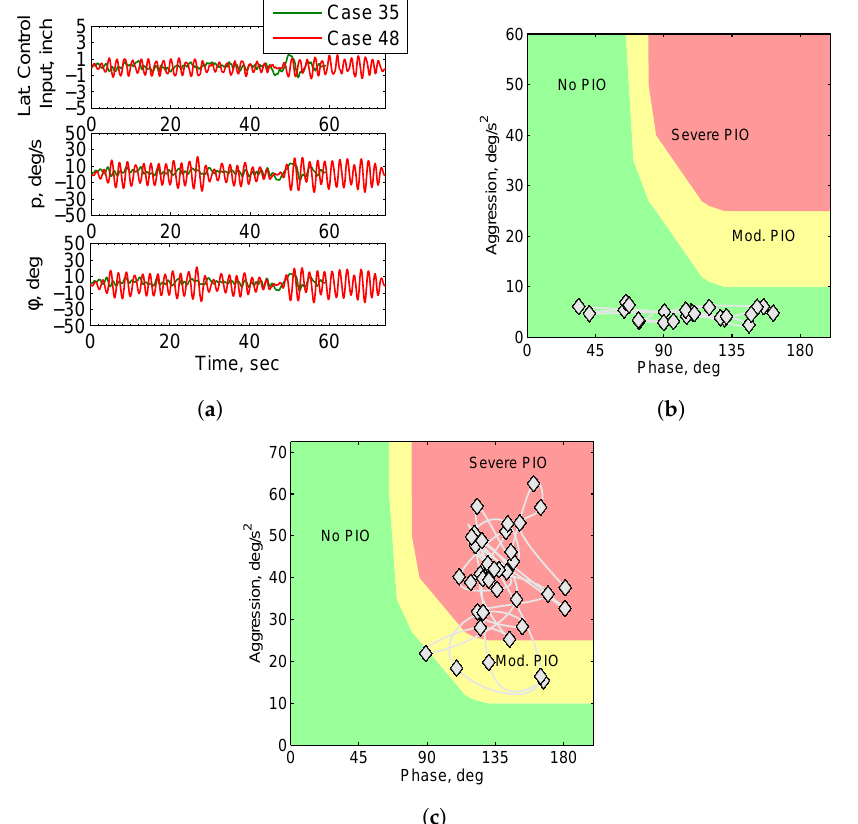
Figure 11. Comparison of example No PIO and severe PIO cases. ( a ) Comparison of time responses; ( b ) PAC results for Case 35, lateral, No PIO; ( c ) PAC results for Case 48, lateral, severe PIO.